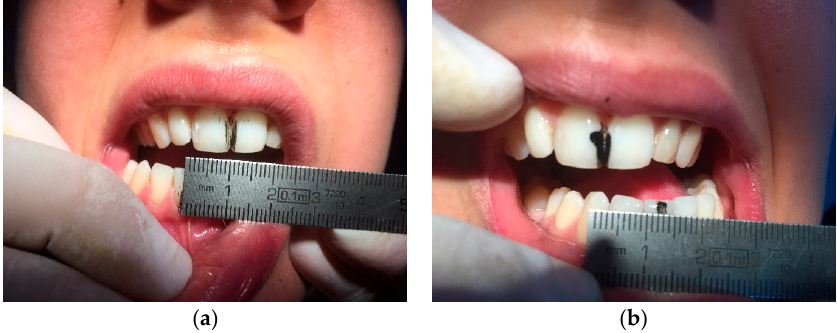
Figure 1. Analysis of the opening pattern of the patient and registration of the maximum pain free opening. ( a ) Middle line has 1 mm deviation to the left side in maximum intercuspation (IM); ( b ) During the condyle rotation the both jaws remain the same misalignment as in IM; ( c ) During the first part of condyle translation it can be seen a deviation to the left side; ( d ) Corrected deviation pattern to the left is confirmed; ( e ) 33 mm of maximum pain free opening.